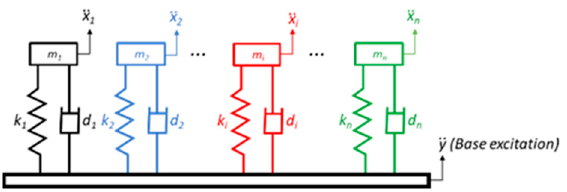
Figure 6. SRS model.